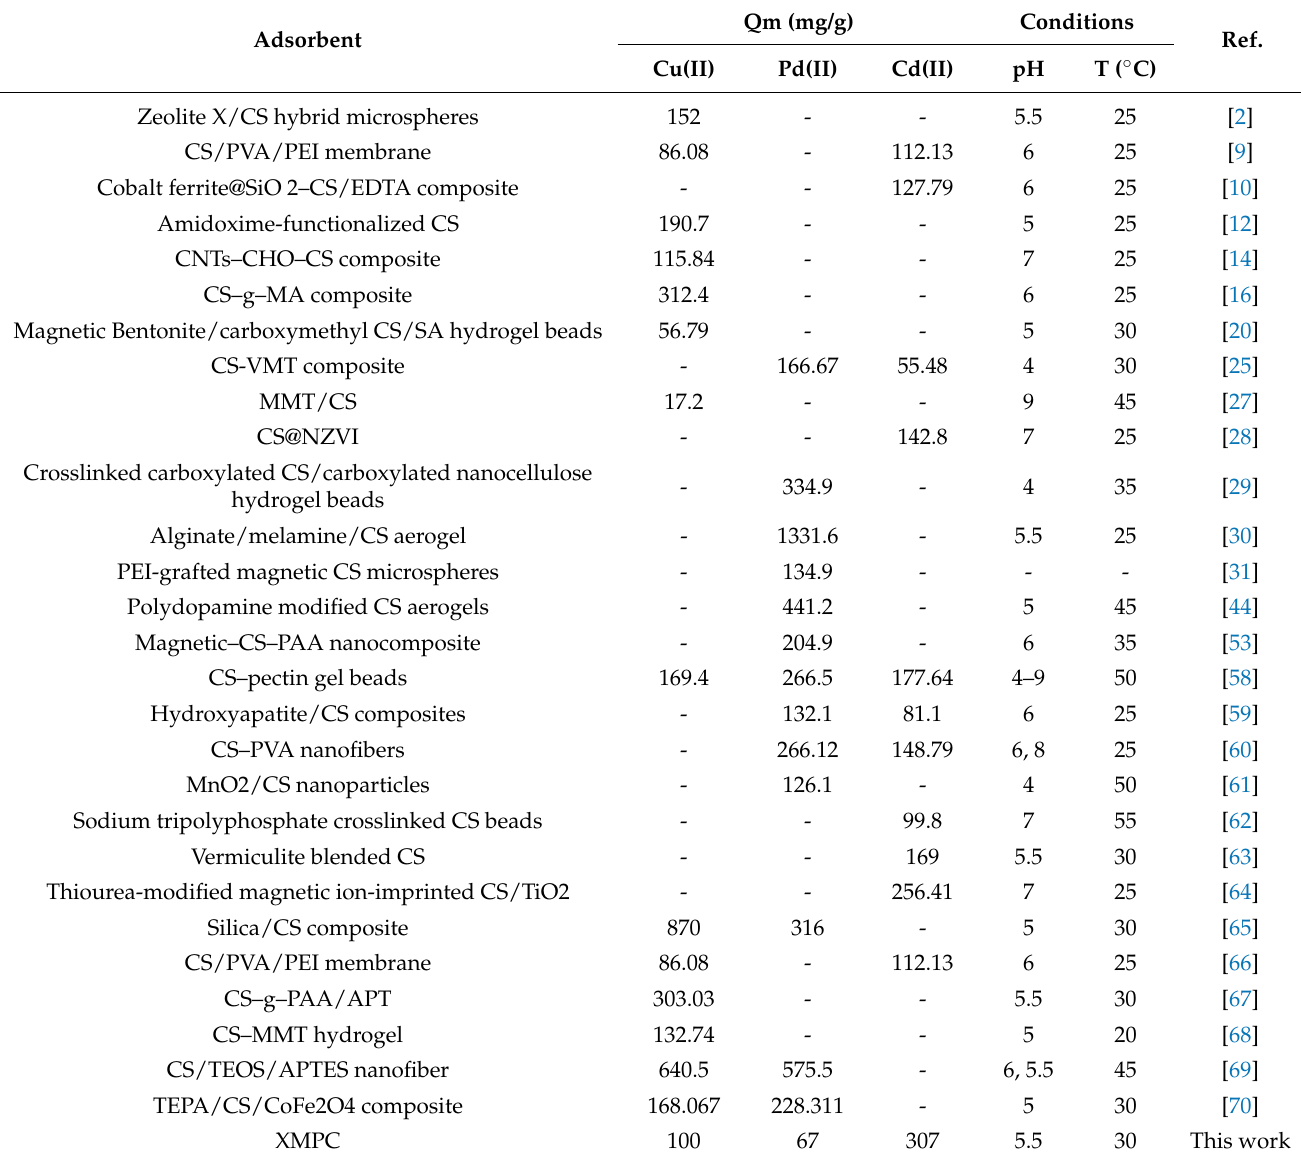
Table 1. Various chitosan-based adsorbents designed for removing of Cu(II), Pb(II), and Cd(II) ions from aqueous solutions.